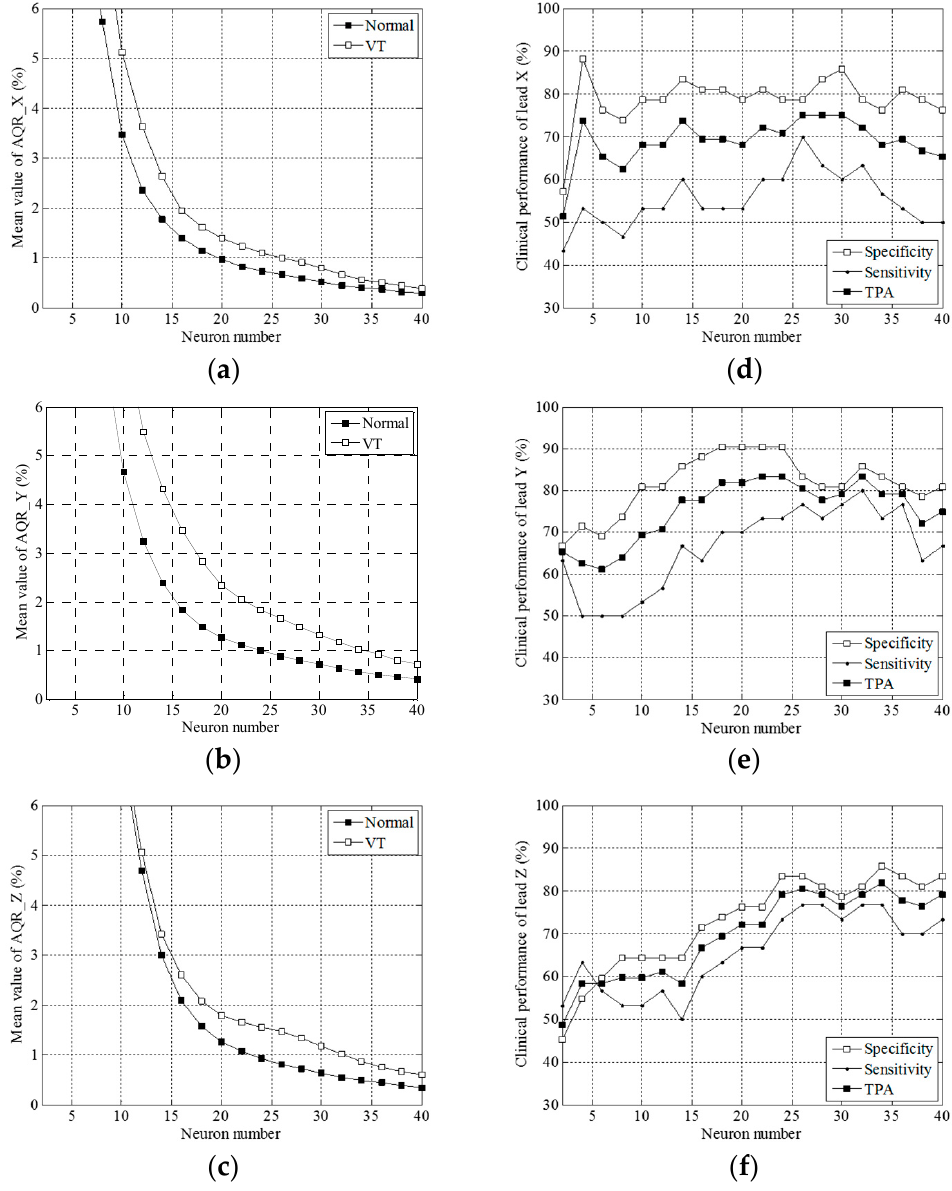
Figure 5. Graphs of the mean AQR vs. the neuron number in leads ( a ) X; ( b ) Y and ( c ) Z, and also, graphs of the clinical performance vs. the spread parameter in leads ( d ) X; ( e ) Y and ( f ) Z, keeping the spread parameter fixed at 20.